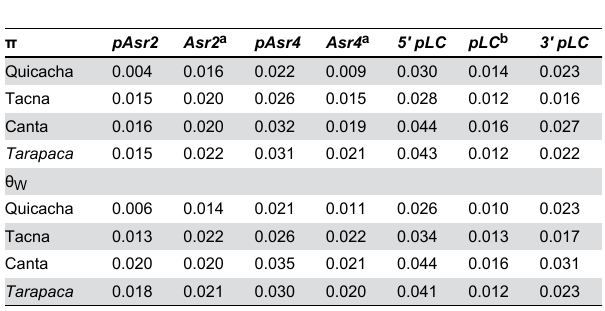
Table 2. Nucleotide diversity of pAsr2 , pAsr4 , 5’pLC , 3’pLC , and their corresponding genes.